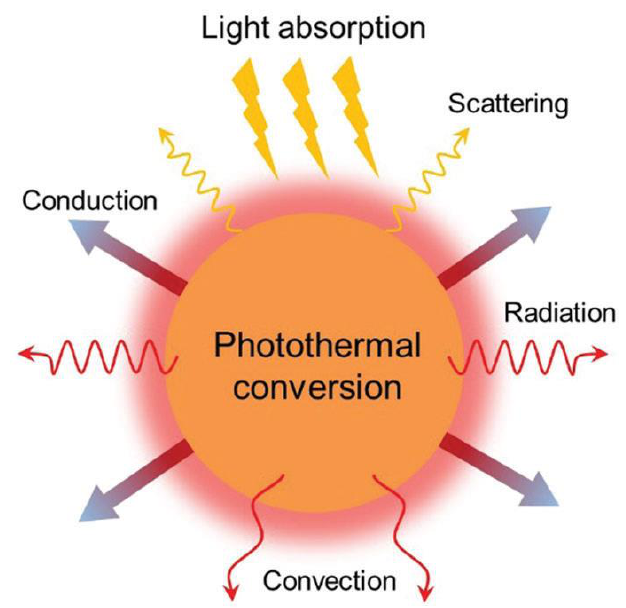
Figure 10. Photothermal energy conversion mechanism by Zhu et al. [55]; 2018, RCS.